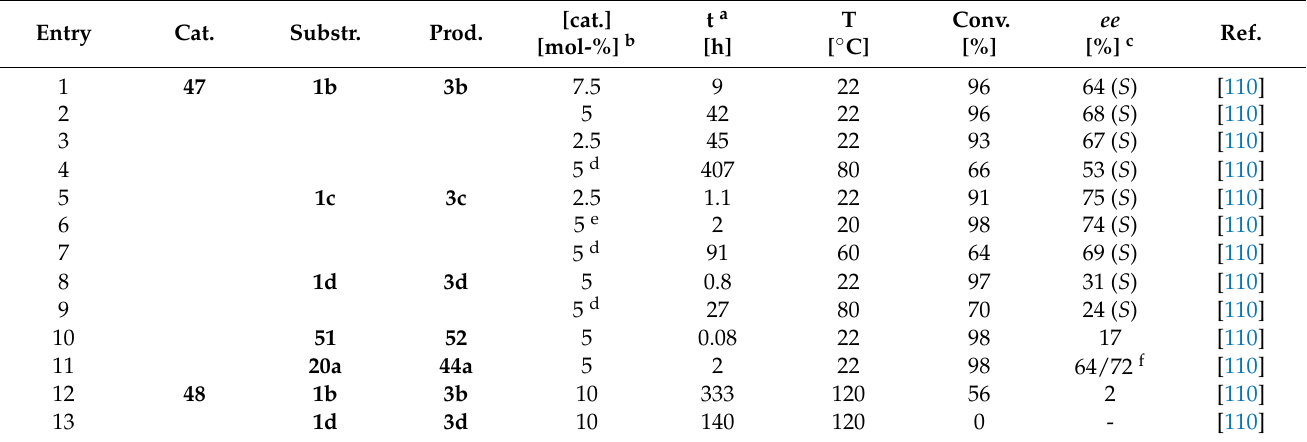
Table 13. Catalytic asymmetric hydroamination of 1b - d , 20a and 51 using chiral lithium catalysts 47 and 48 a . Entry Cat. Substr. Prod. Cat.